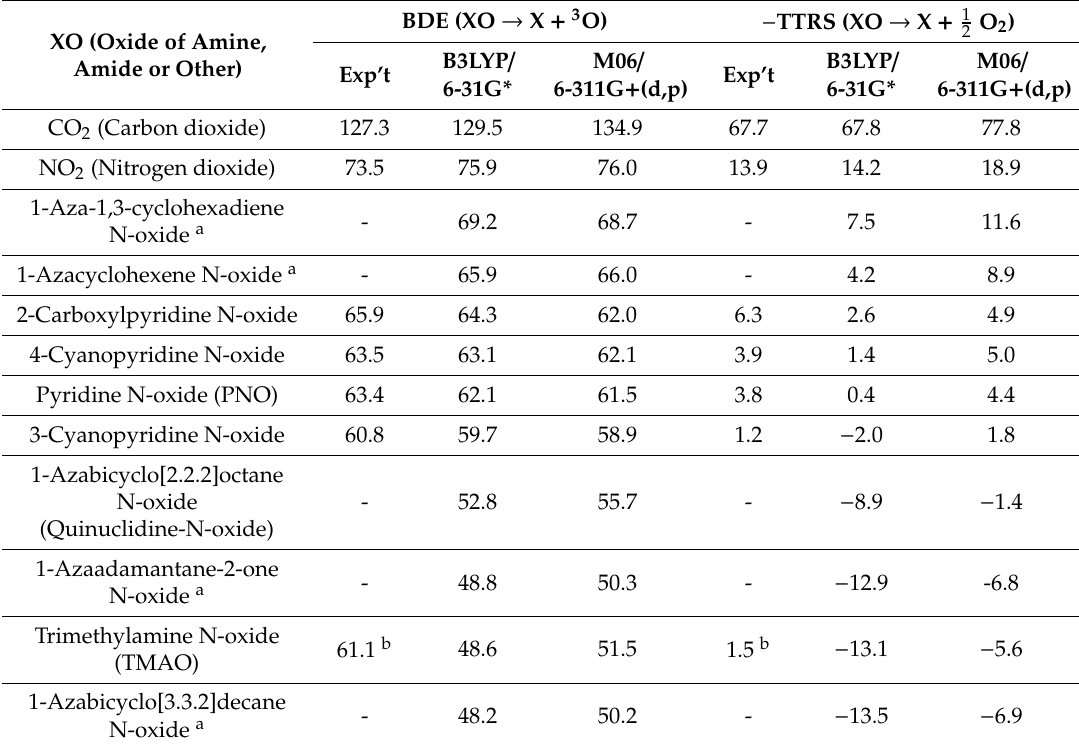
Table 3. Bond dissociation enthalpy (BDE) scale (XO → X + 3 O) and (reverse) transfer thermodynamic reactivity scale ( − TTRS: XO → X + 1 O 2 ) (simply the reverse of the scale in Table 19 of reference [14]). 2 All values are in kcal / mol. See Supplemental Information for Kekul é